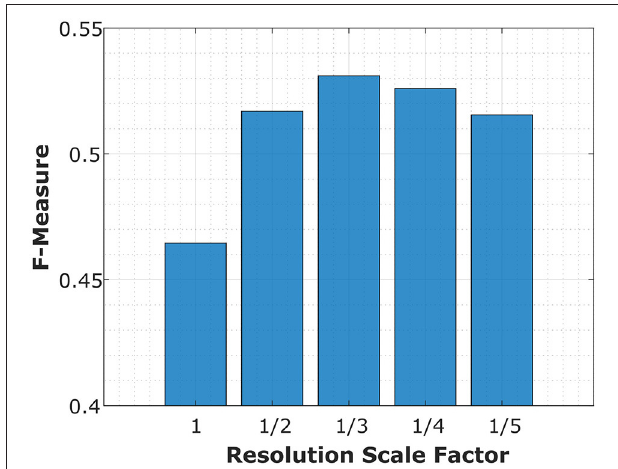
FIGURE 6 | The effect of image resolution on circuit performance. The benchmarking score (F-Measure) is plotted against the scale factor of the image resolution. An improvement in performance is observed for lower resolution images. For example, the highest score occurred when the images were at a 1/3 of their original resolution. It was not possible to investigate the effect of increasing image resolution as there were no high resolution images available for the